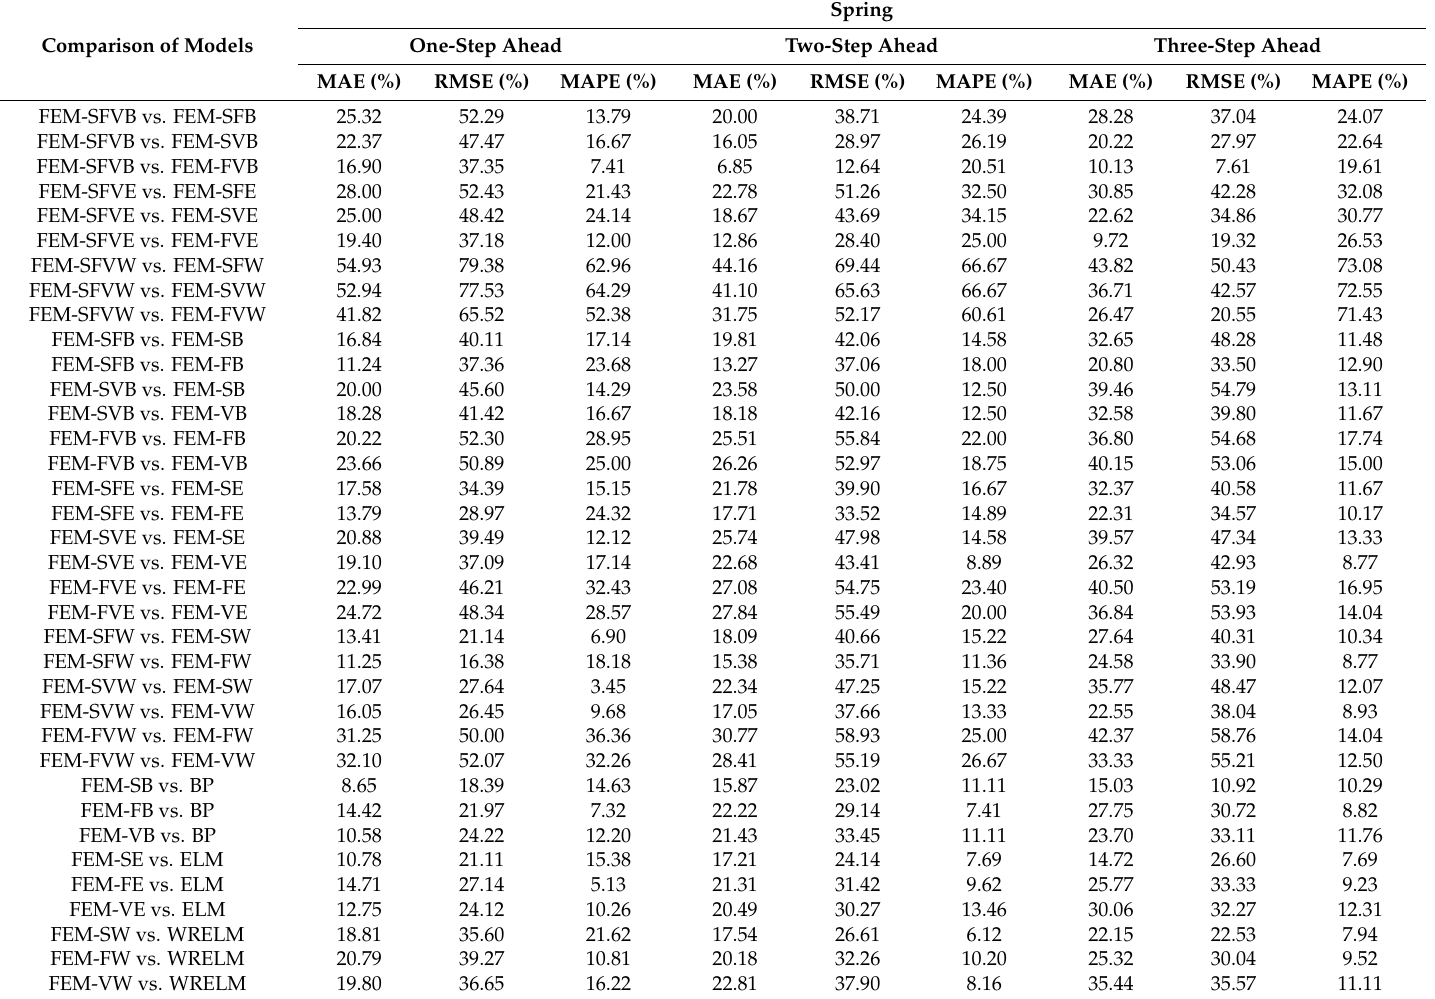
Table 11. Comparison results of experiments III, IV and V in